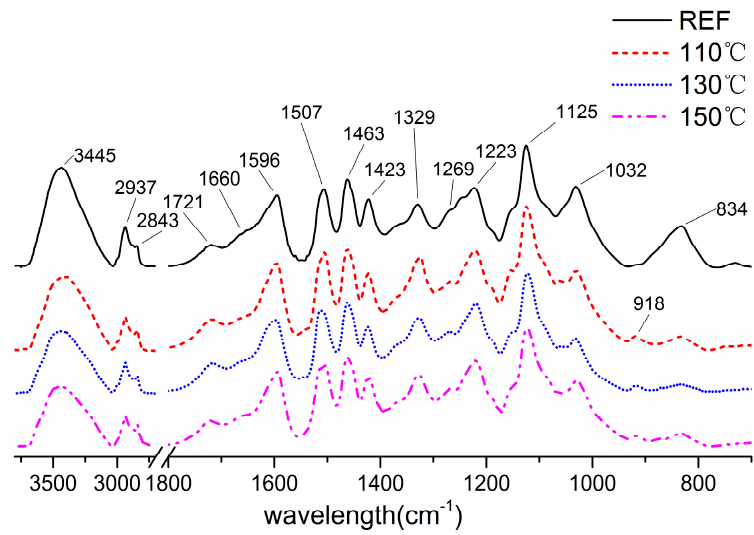
Figure 3. The FTIR spectra of dioxane lignin extracted from samples untreated and treated.